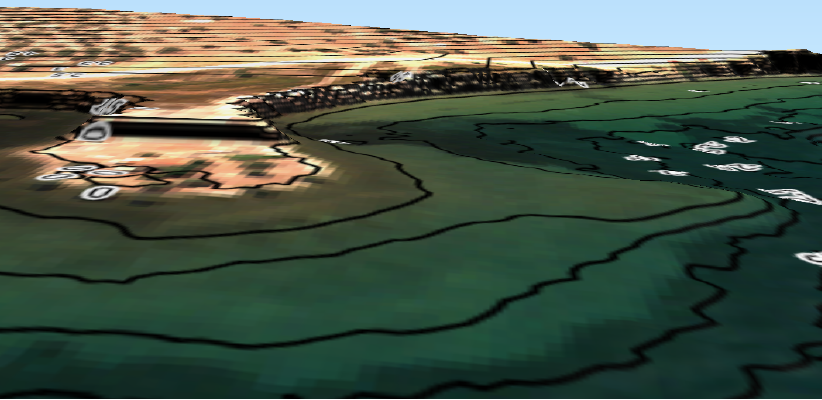
Figure 18: True colour composite WorldView-2 image overlaid on a combined bathymetry and SRTM digital elevation